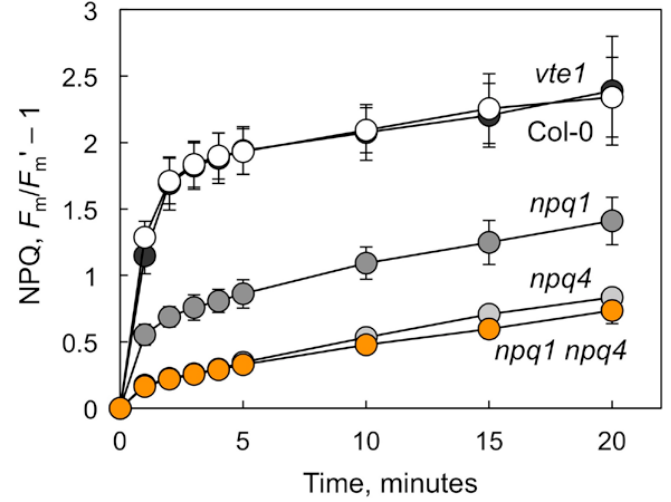
Figure 1. Time course of the development of non-photochemical quenching of chlorophyll fluorescence (NPQ) under 2% O 2 (balance N 2 ) and 2000 µmol photons m –2 s − 1 at 25 °C. Mean values ± standard deviation, n = 3 or 4, from the leaves of wild-type Col-0 (open symbols) and vte1 (dark gray symbols), npq1 (medium gray symbols), npq4 (light gray symbols), and npq1 npq4 (orange symbols) mutants of Arabidopsis thaliana grown at 35 °C. Differences between Col-0 and the npq1 , npq4 , and npq1 npq4 mutants at all of the time points were highly significant ( p < 0.001; Student’s t -test). There were no significant differences between Col-0 and vte1 .